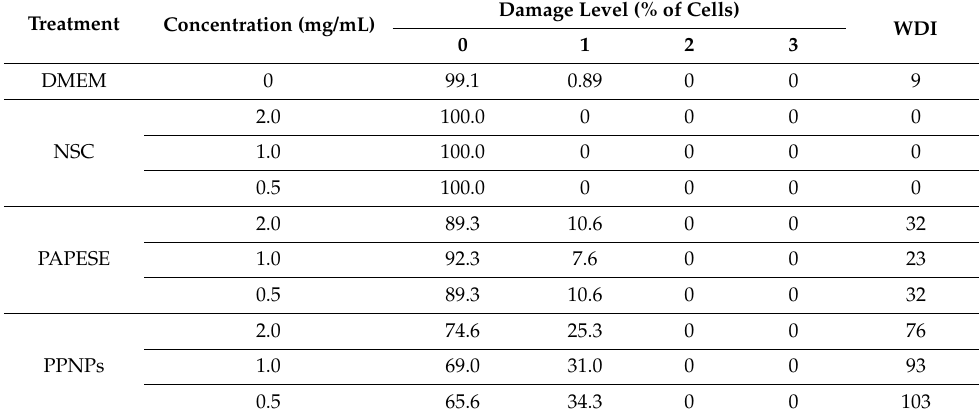
Table 4. Percentage of cells found in each damage category and weighted damage index (WDI).